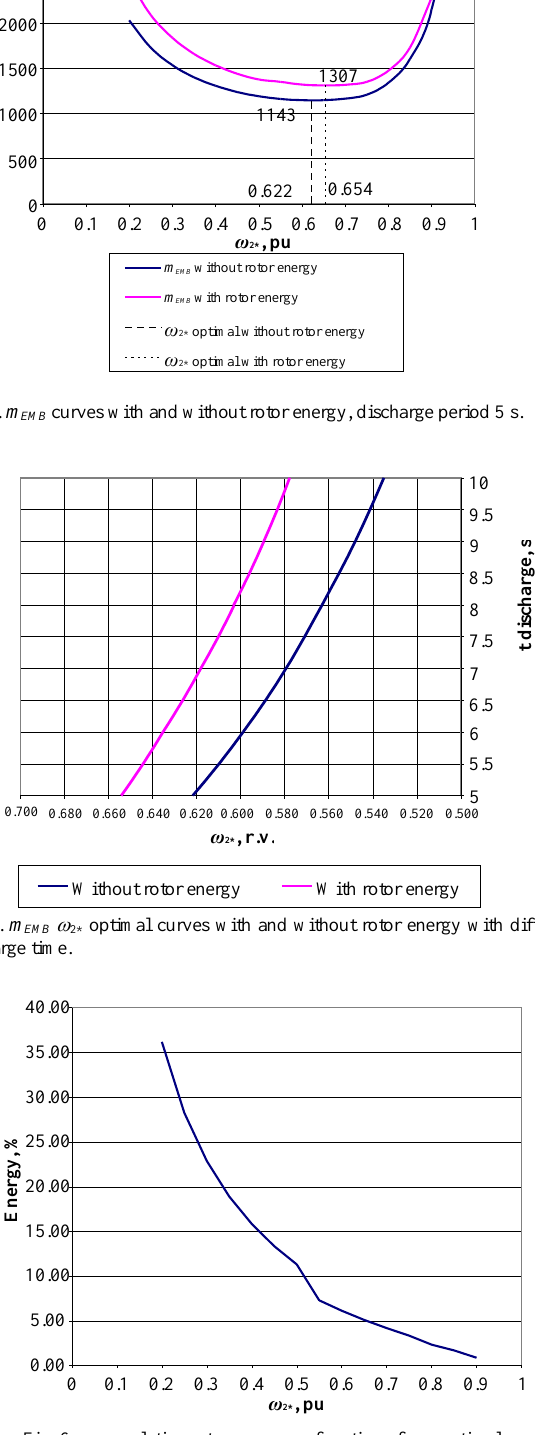
Fig. 6. m EMB relative rotor energy as function of  2*